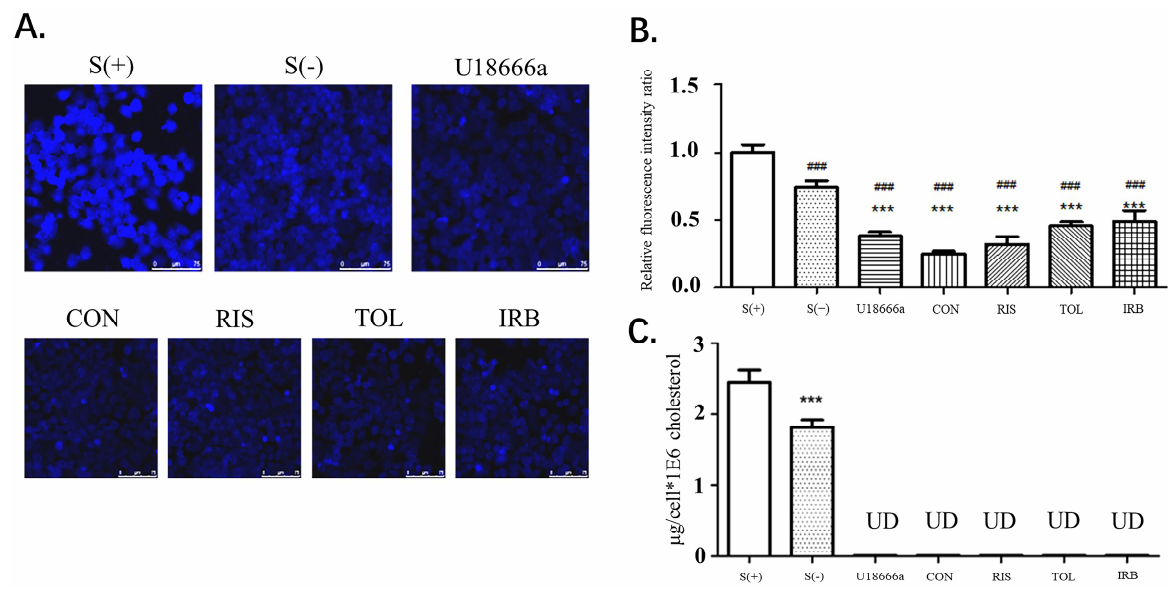
Figure 4. Four candidates inhibited the decrease in the intracellular cholesterol levels of HepG2 cells. ( A ). HepG2 cells were fixed with 4% formaldehyde and treated with filipin at 37 ◦ C for 2 h. After washing with PBS, the cells were viewed by fluorescent microscopy. CON is conivaptan; RIS is risperidone; TOL is tolvaptan; IRB is irbesartan. ( B ). Fluorescence determined using the Image-J software. Data are expressed as means ± SD. T-test and ANOVAs were used for the comparison of two groups and multiple groups, respectively ( n = 30 for each group). ###: p < 0.01 vs. S(+), ***: p < 0.01 vs. S( − ). ( C ). HPLC analysis of the intracellular cholesterol content. UD: undetectable n = 3, mean ± SD, ***: p < 0.01 vs. S (+).